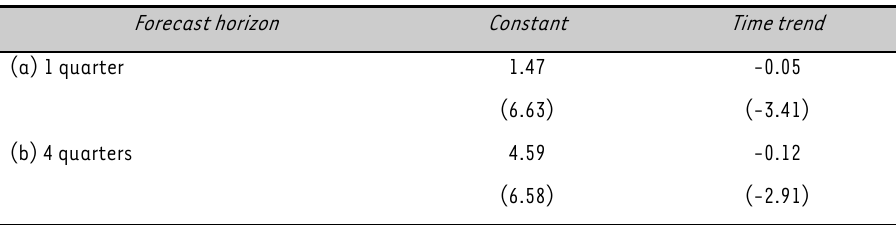
TABLE 5: Forecast dispersion, March 2000-December 2006 (dependent variable: forecasts of the prime rate, quarterly